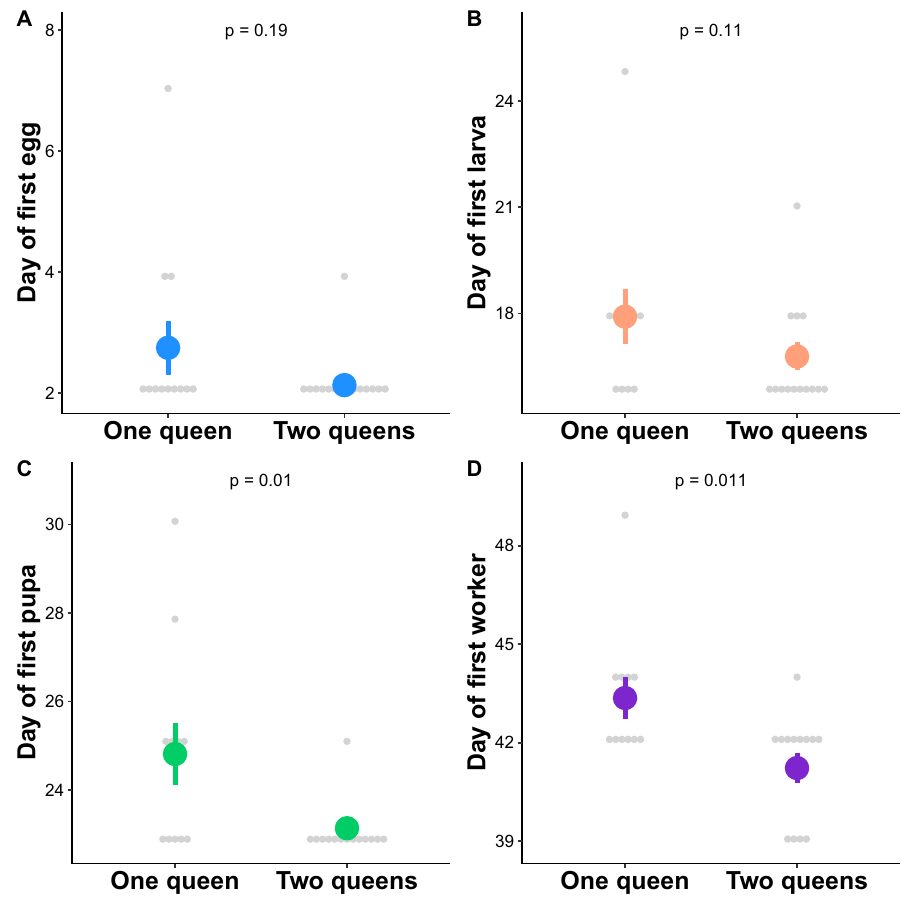
Figure 2. Effect of queen number on the day (mean ± s.e.) when the first ( A ) eggs, ( B ) larvae, ( C ) pupae, and ( D ) workers were recorded in the